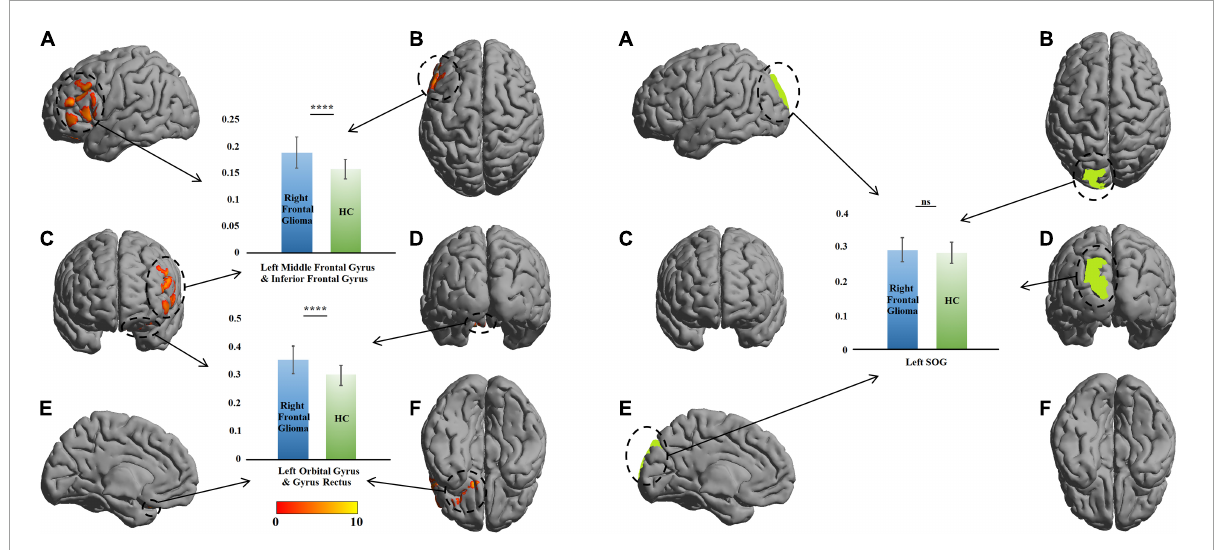
FIGURE3 Comparison of gray-matter volume (GMV) between the patients with right frontal glioma and healthy controls (HCs). The warm colors (red to yellow) indicate the significant area (the right orbital gyrus and gyrus rectus) with the right frontal GM indicated as the mask. Green color indicates the right superior occipital gyrus (SOG). The GMVs of the patients and HCs are presented as histograms. ns, not significant. **** P ≤ 0.0001. (A) left view; (B) top view; (C) , anterior view; (D) posterior view; (E) right view (only left cerebral hemisphere); (F) bottom view.